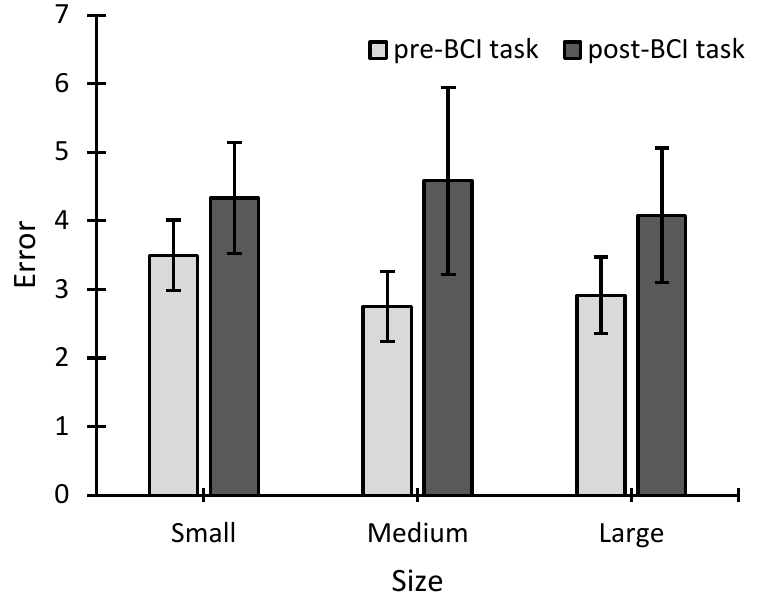
Figure 3. Errors (mean ± standard error, for 50 stimulus presentations in each column) during the perceptual task, for each size, for both the perceptual tasks before and after the brain–computer interface task.